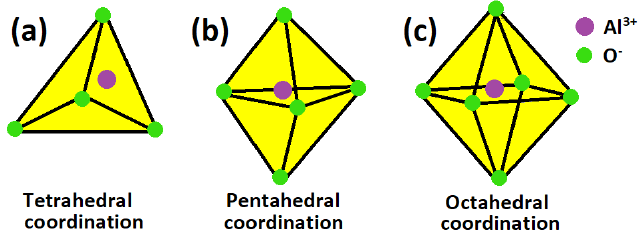
Figure 2. Schematic illustration of the three ways in which aluminum cations coordinate with oxygen anions in the porous anodized aluminum oxide layer (octahedral coordination is reported [78,87] to be enhanced by sealing at the expense of tetrahedral coordination).